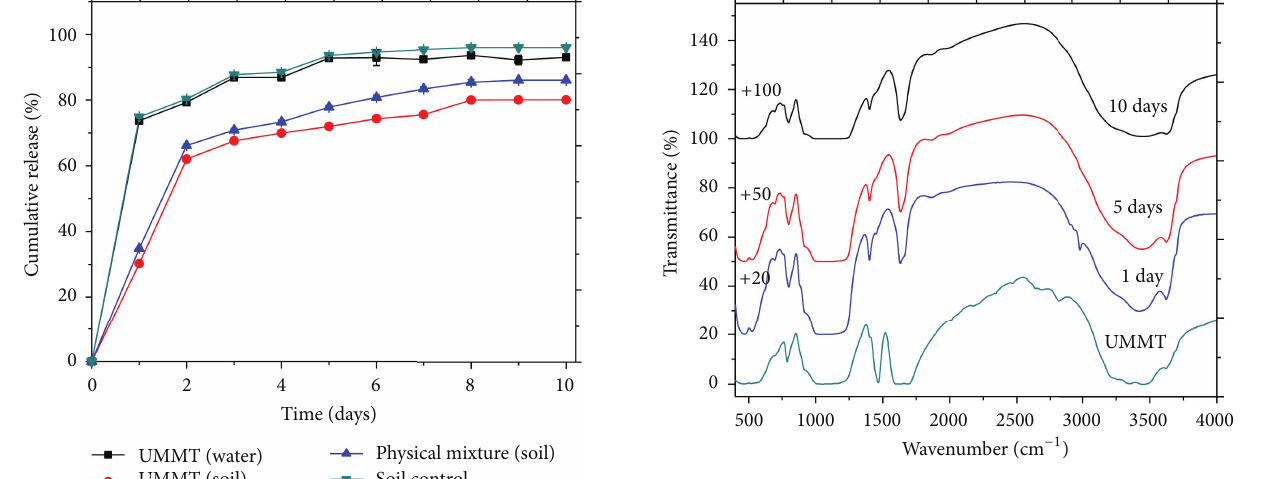
Figure 12: IR spectrum of UMMT and corresponding spectra after releasing urea in water for different